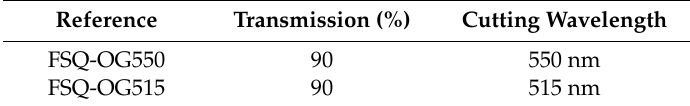
Figure 5. Experimental assembly. ( 1 ) Structure; ( 2 ) variable resistance; ( 3 ) ammeter and ( 4 ) voltmeter. Table 1. High-pass filter characteristics.